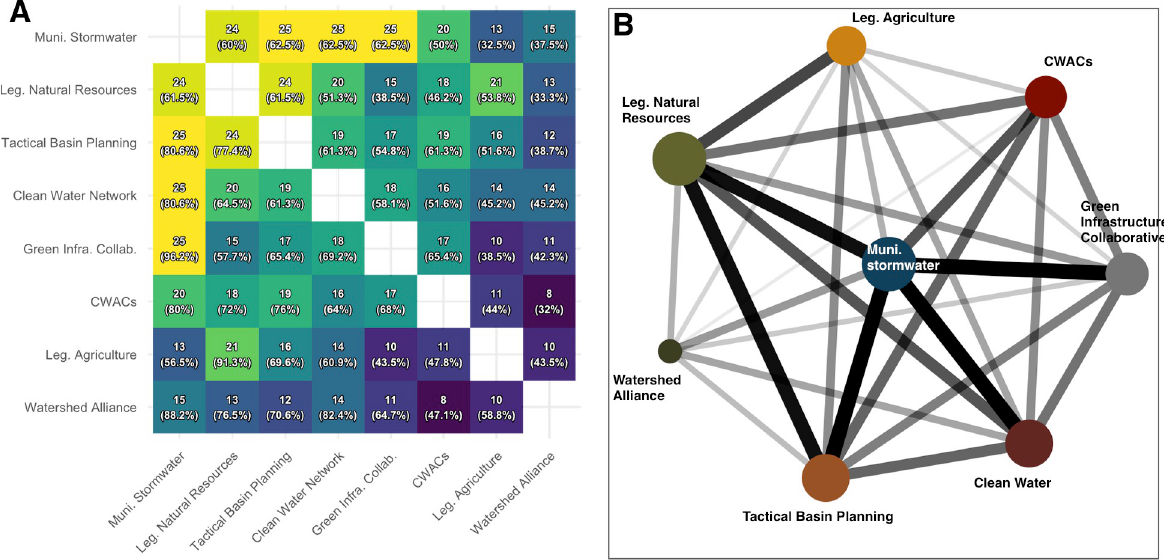
Fig 2. Connected action situations. (A) Joint participation in the various action situations. Values correspond to the number of actors jointly participating in action situation pairs. The percentage of actors participating from the action situation listed on the left are shown in parentheses. (B) Action situation relationships plotted as an undirected graph. Node size is scaled to the number of participant). Width and shading of edges are scaled according to co-participation.